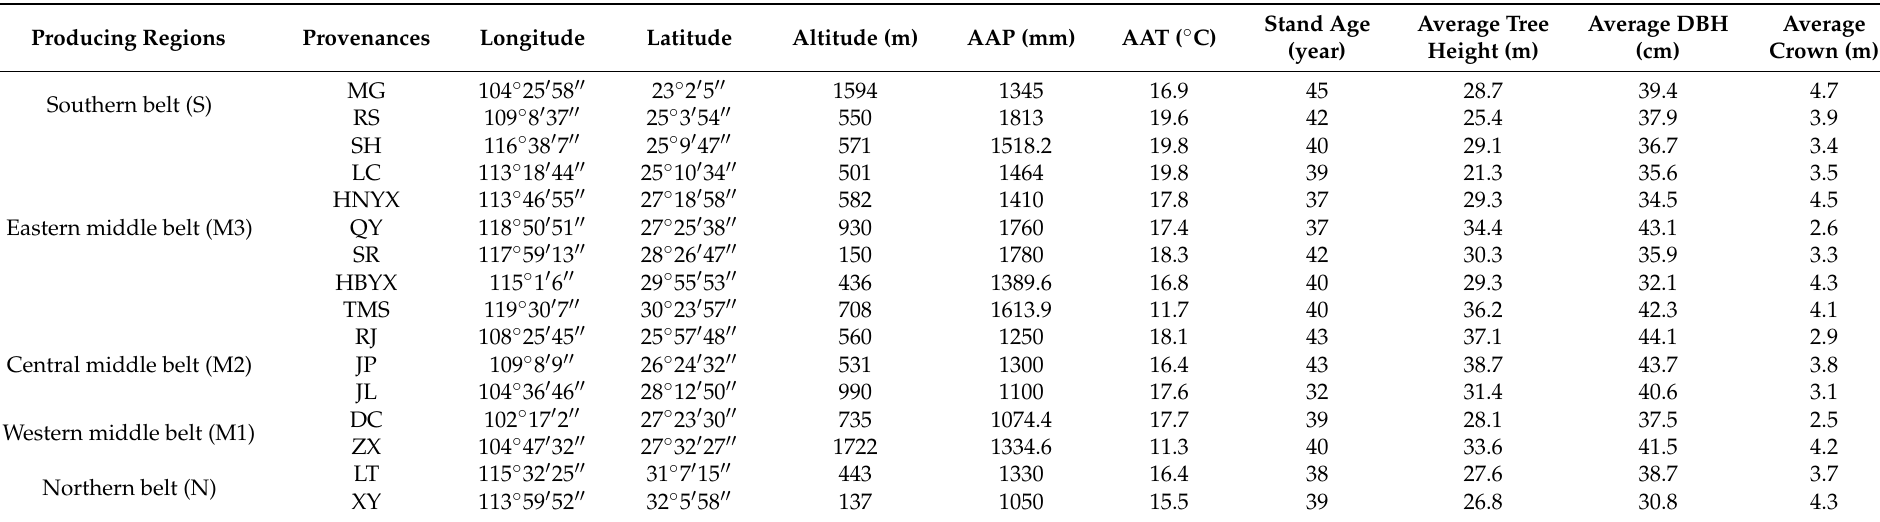
Table 1. Sample plot details, including geographical location (longitude, latitude, and altitude), climate factors (annual average precipitation (AAP) and annual average temperature (AAT))and growth